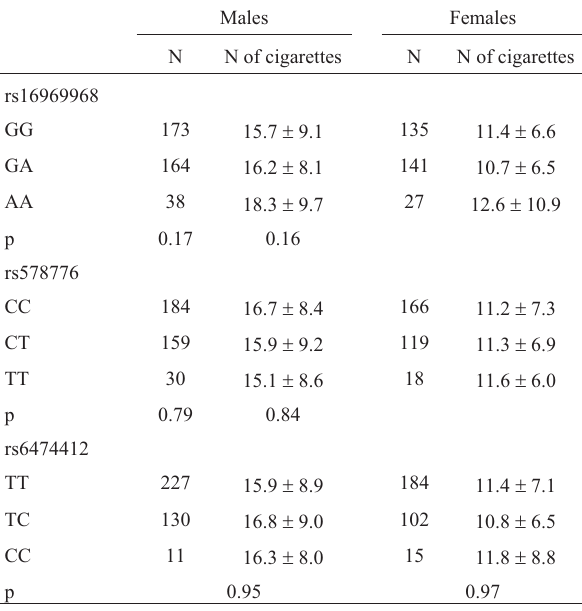
Table 3 - Number of cigarettes smoked per day according the cholinergic receptor gene genotypes. Uncorrected p-values for genotype differences between the subgroups are given (all p = n.s.). Data from the survey per- formed in 2000/2001 are presented.